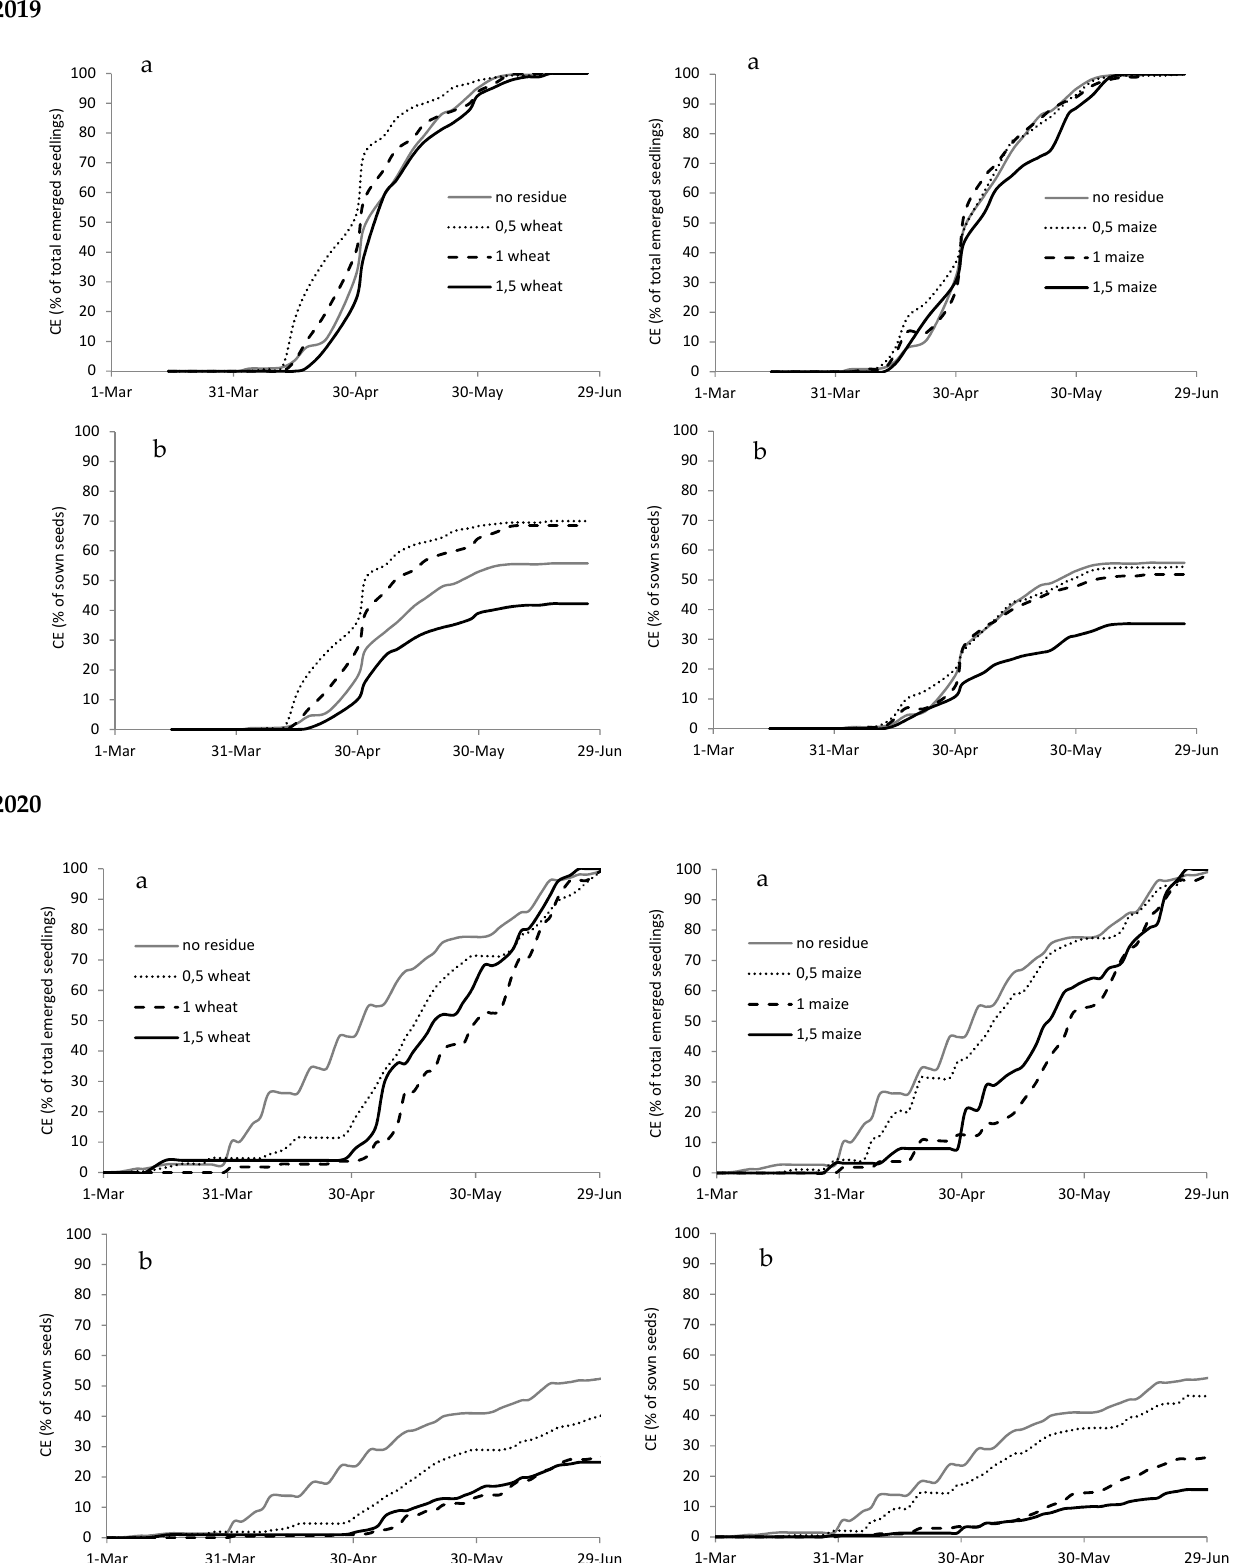
Figure A5. Cumulated emergence (CE) expressed as percentage of total emerged seedlings ( a ) and as percentage of sown seeds ( b ) of Echinochloa crus-galli in 2019 and 2020 with different types (wheat on the left and maize on the right) and amounts of crop